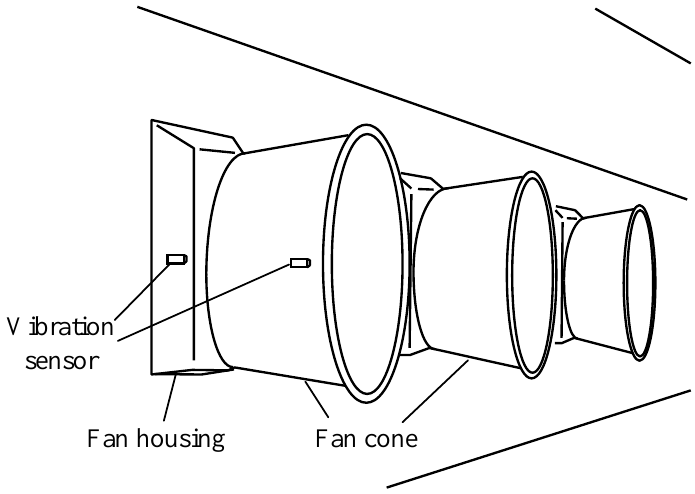
Figure 2. Mounting locations of vibration sensor on the fan housing or fan cone [14].